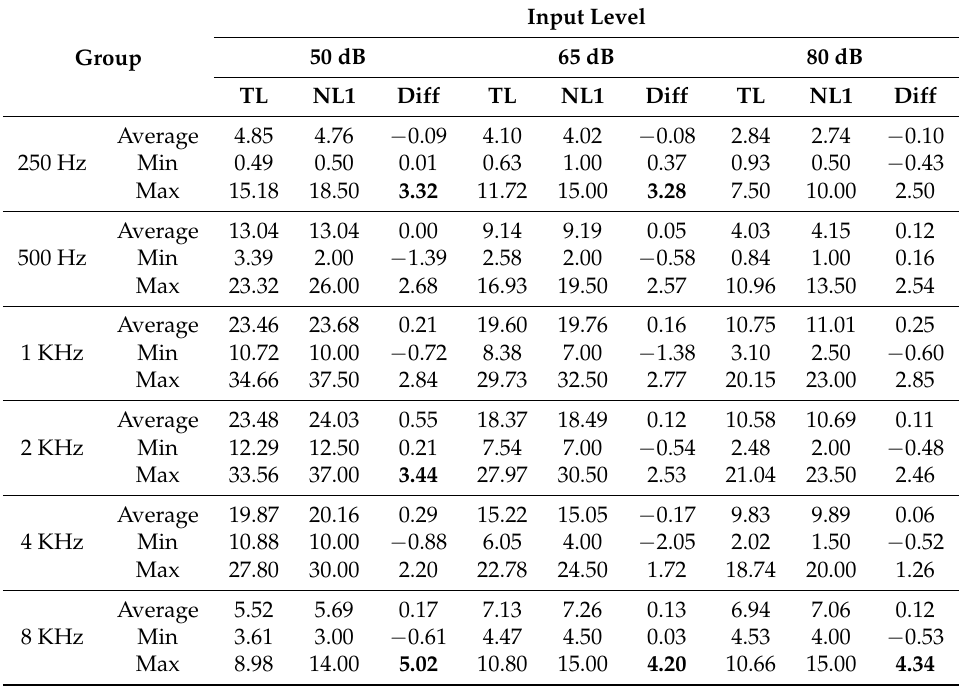
Table 2. Statistical analysis of NAL-NAL1.